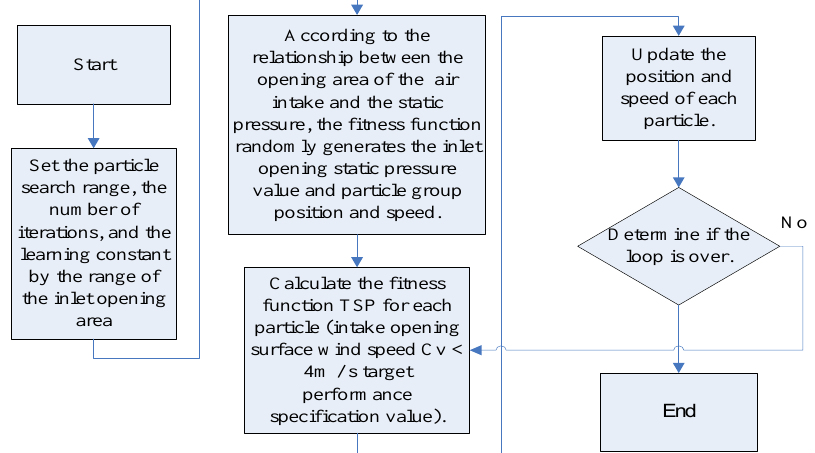
Figure 2. Optimized design flowchart for the equipment room inlet opening area and static pressure.